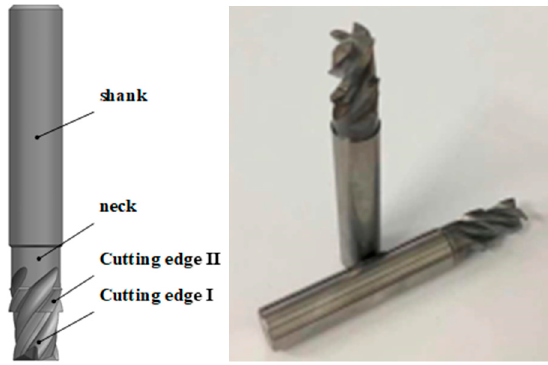
Figure 8. The structure of step-cutter. Table 6. The parameters of step-cutter.